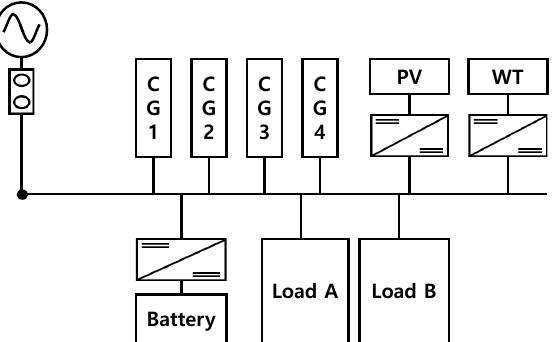
Figure 1. The MG model considered in this study.